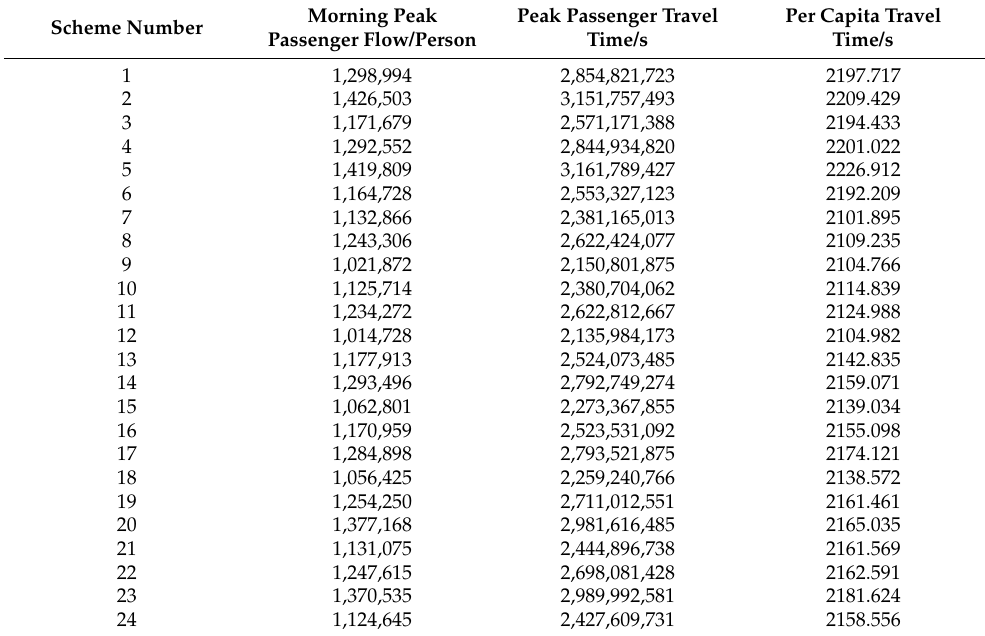
Table 7. Simulation results of hybrid optimization